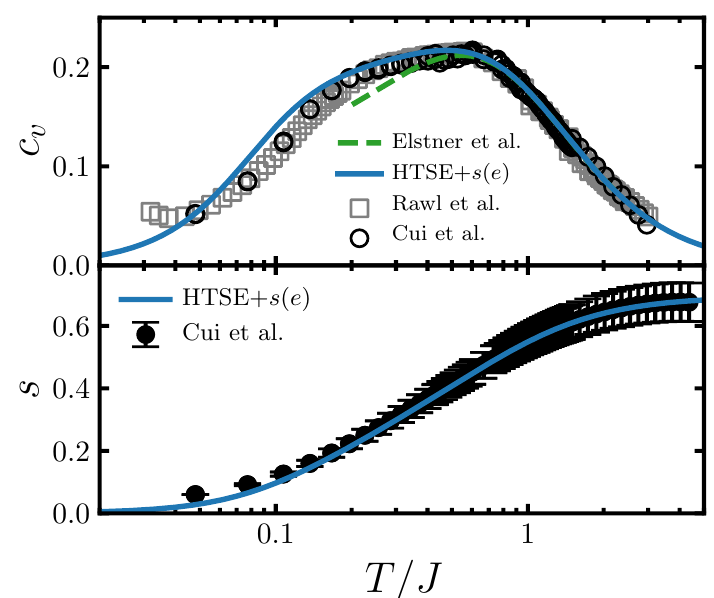
Figure 4: Calculations of the specific heat c of the triangular lattice Heisenberg model using HTSE + s ( e ) , compared with the ex- perimental measurements made by Rawl et al. and Cui et al. on the compound [ 37, 38 ] , and with the Padé Approximants calculations by Elstner et Ba CoNb O 8 6 24 al. [ 7 ]